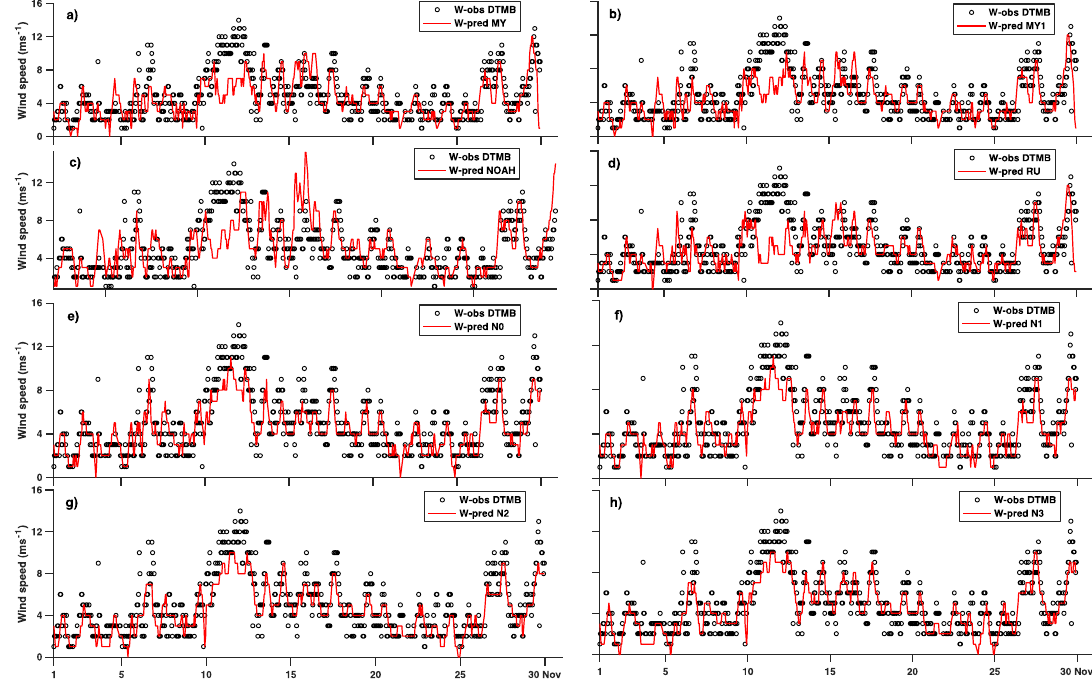
Figure 3. Time series of wind speed observed at DTMB meteorological station versus wind speed predicted by MY ( a ), MY1 ( b ), NOAH ( c ), RU ( d ), N0 ( e ), N1 ( f ), N2 ( g ), and N3 ( h ) simulations.